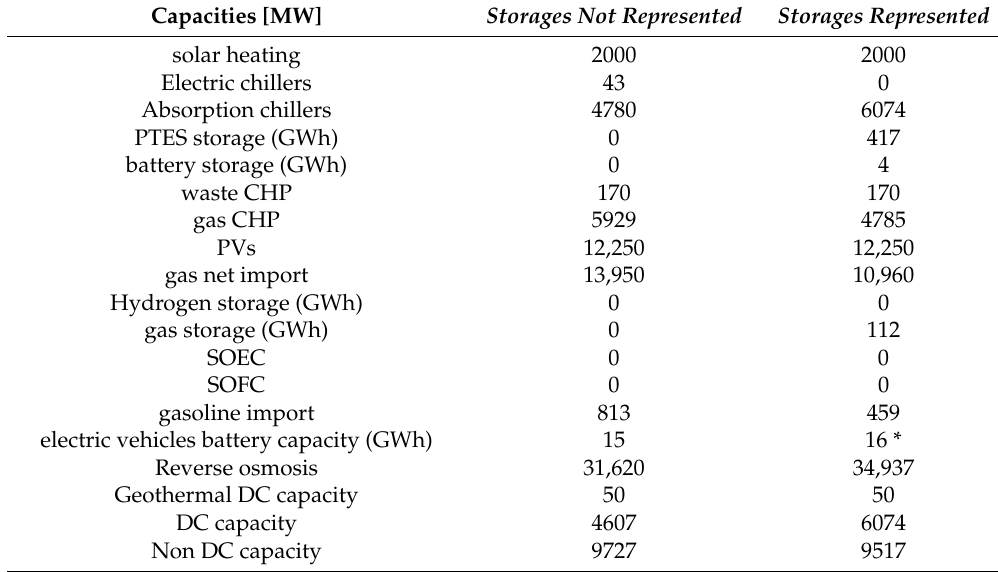
Table 4. The difference in the optimal energy system configuration with and without representation of large scale storages. Only non-zero capacities are presented (including all the storages). Optimal capacities were the one that resulted in the lowest socio-economic costs, for valid conditions in each of the specific scenarios. Capacities [MW] Storages Not Represented Storages